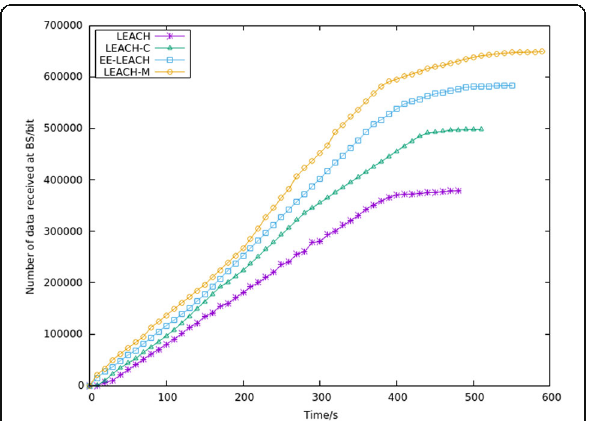
Fig. 10 The comparison of received data at BS for LEACH, LEACH-C, EE-LEACH, and LEACH-M in 300 × 300m 2